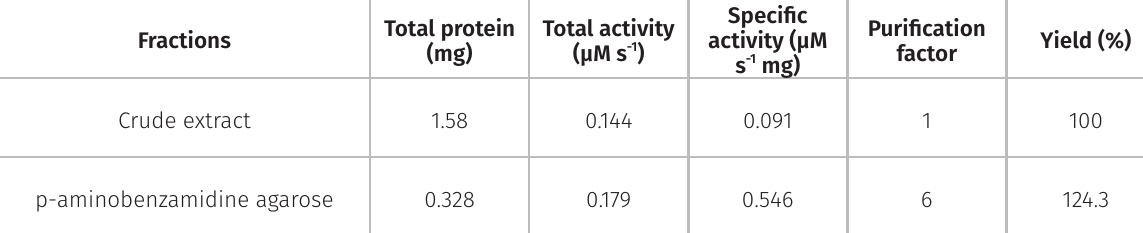
Table I. Partial purification of digestive serine proteases from Anticarsia gemmatalis (Lepidoptera: